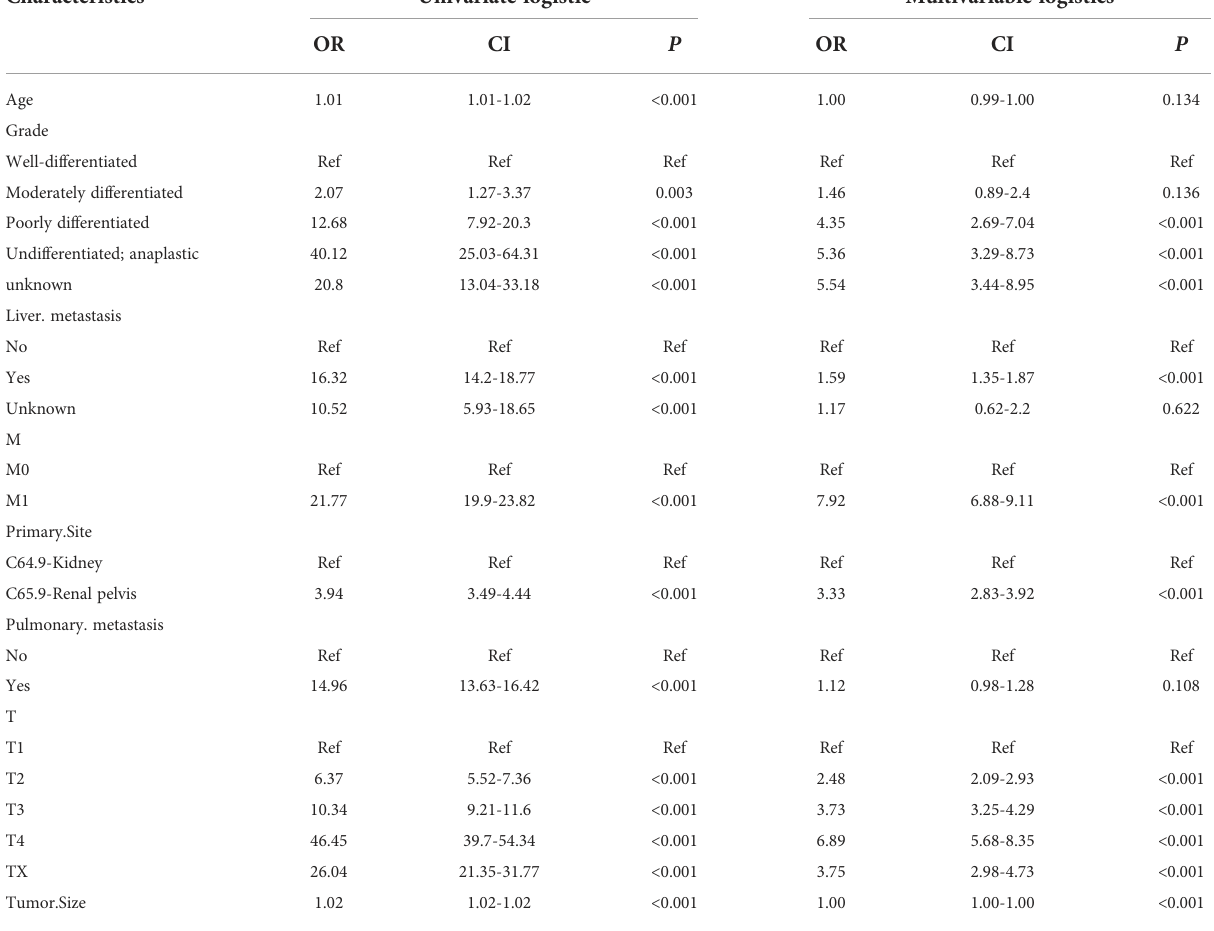
TABLE 2 Univariate and multivariate logistic regression analysis of risk factors for lymph node metastasis in patients with renal cell cancer. Characteristics Univariate logistic Multivariable logistics OR